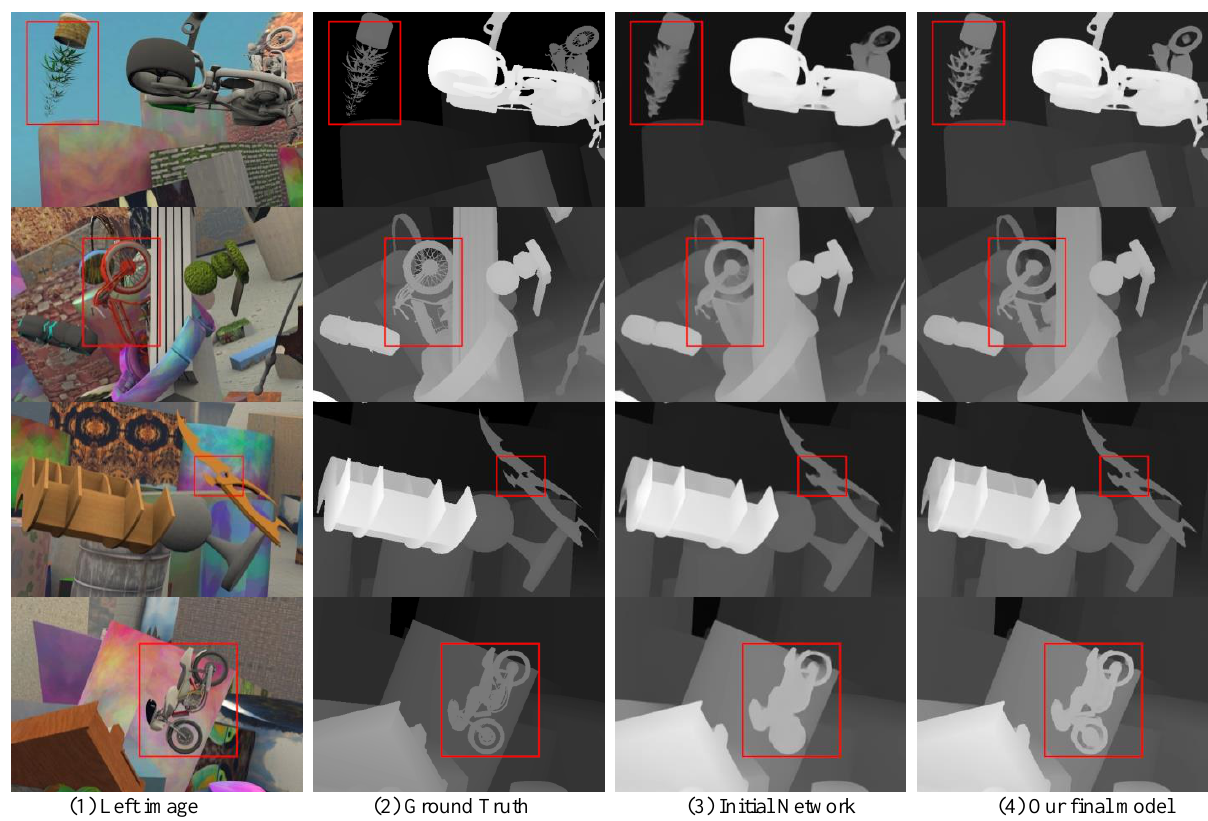
Figure 6. Visualization results of disparity estimation for Scene Flow. Colum 1: Left image; Colum 2: ground truth; Colum 3: results predicted by the initial network (without the refinement). Colum 4: results predicted by our final model (with the